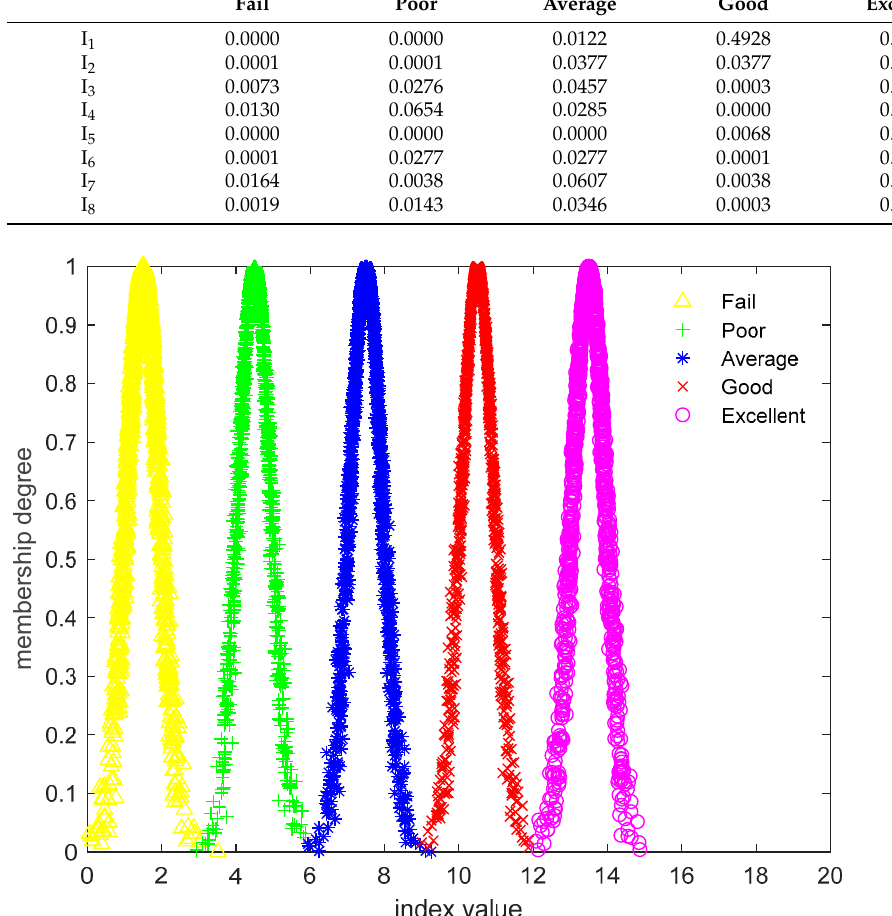
Figure 5. Cloud drop chart of indicator I 1 .